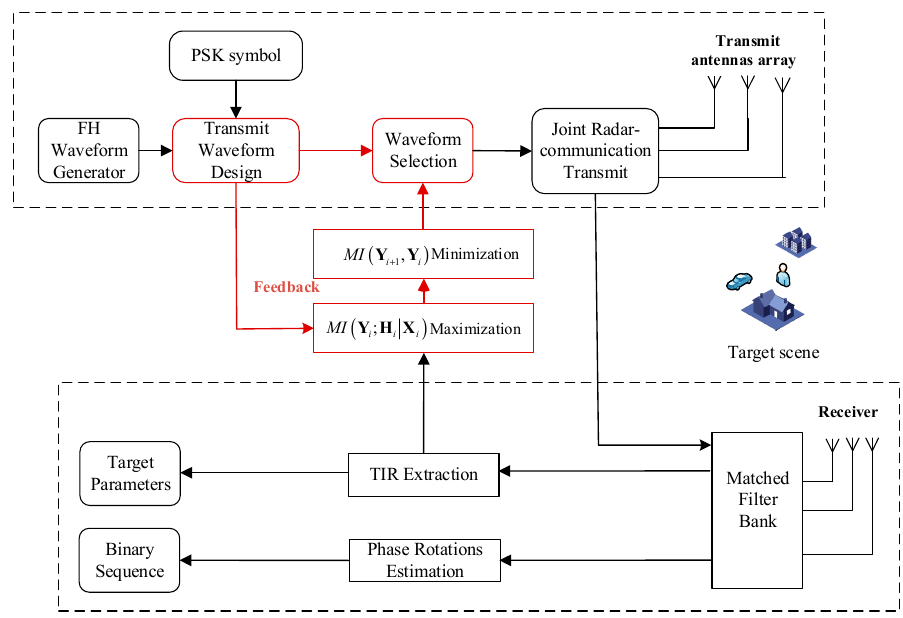
Figure 2. The architecture of an adaptive dual-function MIMO radar communication system.